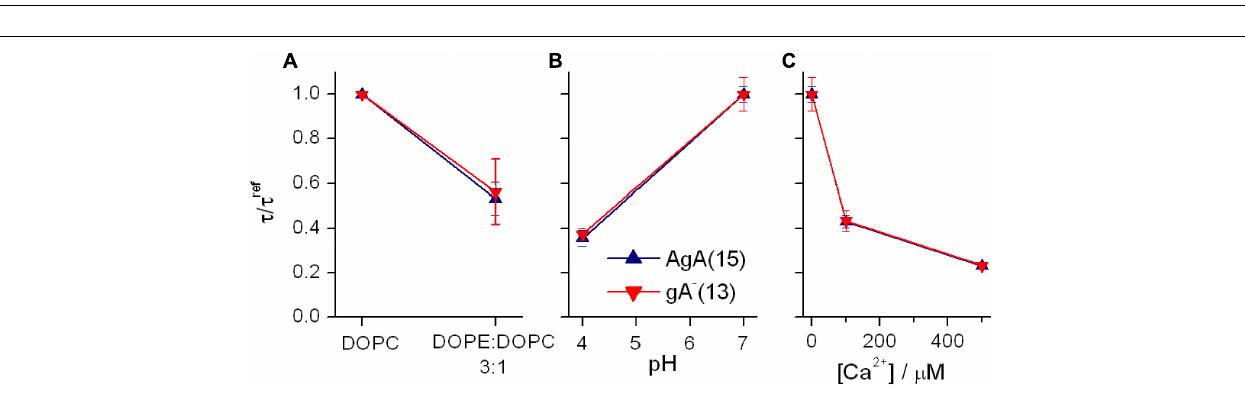
FIGURE 8 | Effects of changes in bilayer composition and head group interactions on AgA(15) and gA − (13) channel lifetimes; results for AgA(15) in blue, results for gA − (13) in red. (A) Effects of varying the DOPE:DOPC molar ratio. The superscript “ref” denotes the value in DOPC bilayers. Experimental conditions as in Figure 7 . (B) Effects of pH on the channel lifetimes in DOPS bilayers. The superscript “ref” denotes the value at pH 7. 0.1 M NaCl. (C) Effects of [Ca 2 + ] on the channel lifetimes in DOPS bilayers. The superscript “ref” denotes the value in the nominal absence of Ca 2 + . 0.1 M NaCl, pH 7. In all panels: mean ± SD, n ≥